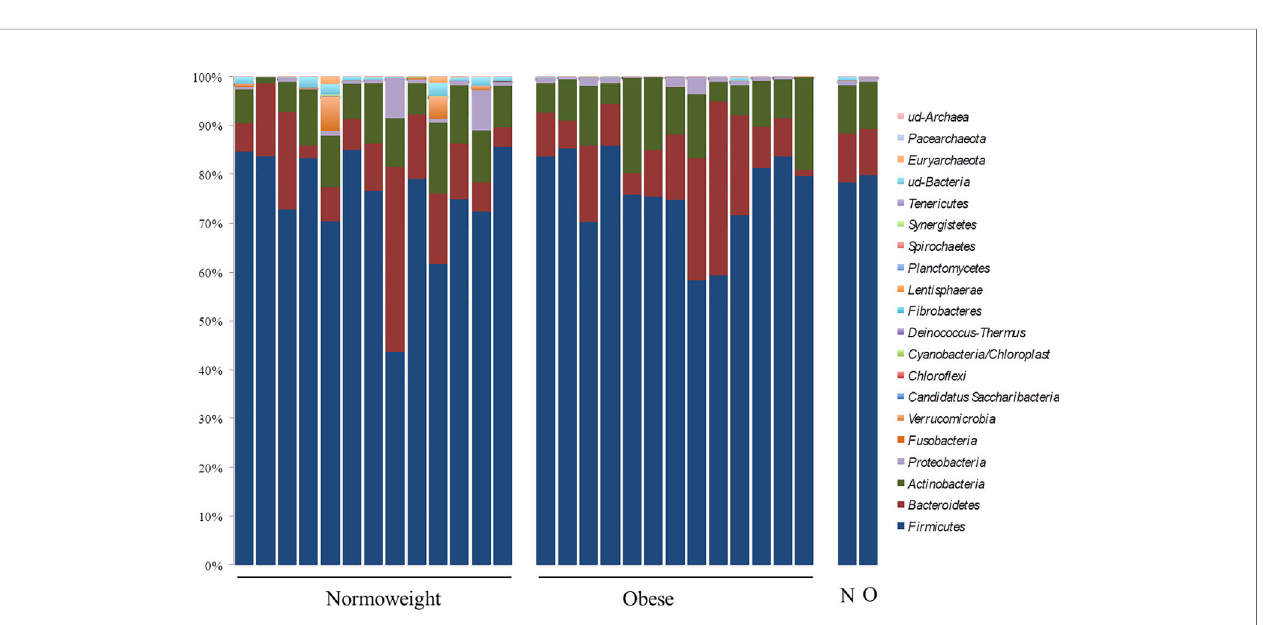
FIGURE 2 | Phylum distribution in the fecal samples analyzed from normoweight (N) and obese (O) individuals. The right columns represent the median value of each group.